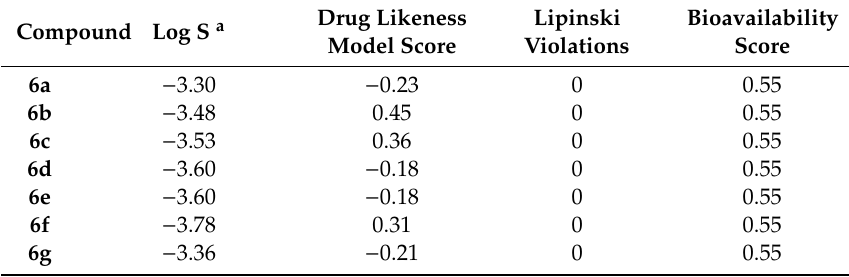
Table 6. Lipinski drug-likeness of the target compounds using Molsoft and Swiss ADME software. Compound Log S